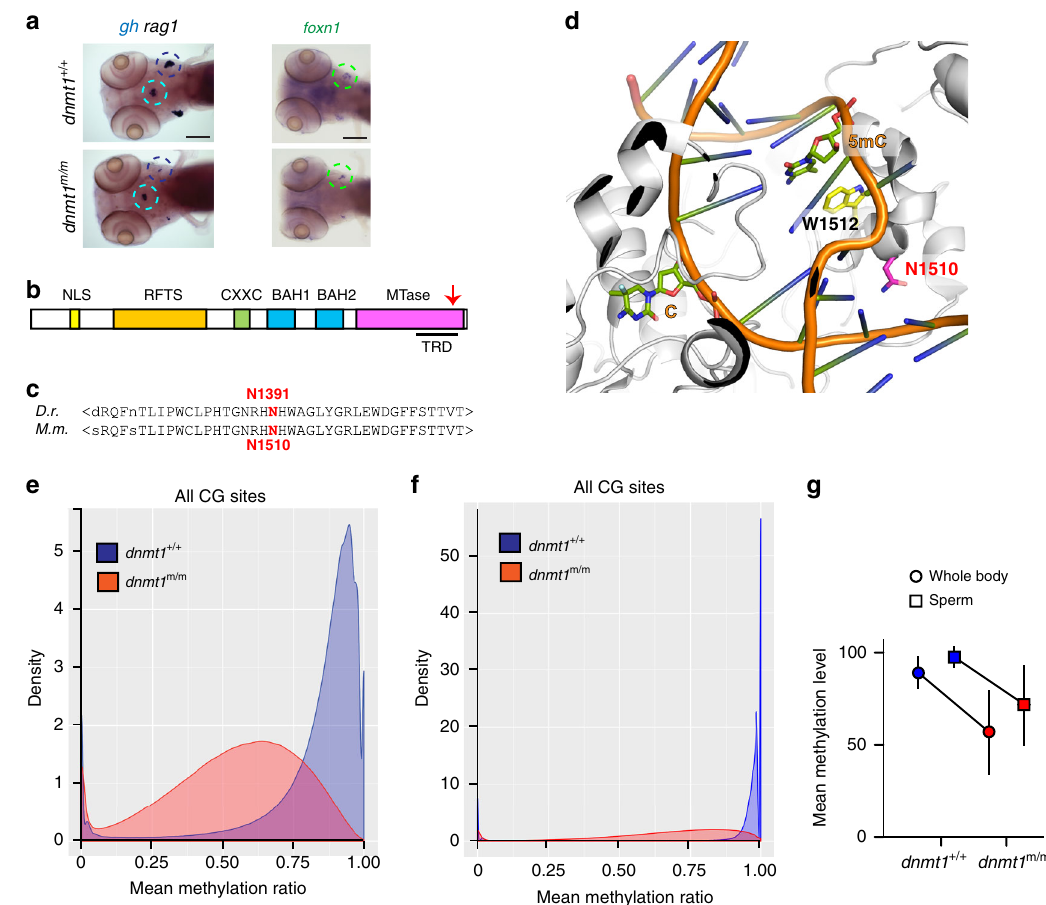
Fig. 1 Characterization of a hypomorphic allele of dnmt1 . a Impaired larval T cell development in mutant fi sh. Diagnostic whole-mount RNA in situ hybridization pattern 23 in wild-type and dnmt1 mutant fi sh at 5 dpf using rag1 (thymus encircled in black), and gh (hypophysis encircled in blue) speci fi c probes (left panel); hybridization pattern for foxn1 , a marker of thymic epithelium 59,60 (right panel). Scale bar, 100 μ m. Panels are representative of 25 animals each. b Schematic of functional domains in the dnmt1 protein (not to scale); NLS, nuclear localization signal; RFTS, replication foci targeting site; CXXC, cysteine-rich domain; BAH, bromo-adjacent homology domains 1 and 2; MTase, catalytic domain. Arrow, approximate position of the amino acid replacement in the target recognition domain, TRD. c The asparagine residue mutated in the dnmt1 t25501 allele occurs in an evolutionarily conserved region of the enzyme. d In the structure of the mouse Dnmt1 protein in complex with a hemi-methylated substrate, close apposition of the mutated asparagine residue to the substrate DNA in the catalytic site is observed 26 (PDB ID: 4DA4). e , f Hypomethylation of cytosine residues in CpG dinucleotides of DNA extracted from whole body of 18 dpf larvae ( e ) ( n = 3) and sperm of adult homozygous mutants ( f ) ( n = 3). In ( e ) and ( f ), density refers to the fraction of CG sites with a particular methylation ratio. g Mean methylation levels of CG dinucleotides for DNAs shown in ( e ) and ( f ). Values shown represent mean ± mad; n = 3. Source data are provided as Source Data